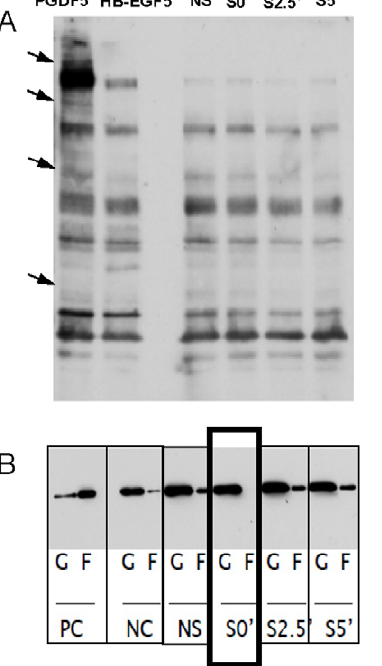
Figure 4. A major component of fluidization is F-actin disassembly: molecular blotting. (A) A transient stretch did not affect phosphotyrosine protein phosphorylation profiles. Positive control: PDGF and HB-EGF treatment for 5 minutes. (B) In contrast, a transient stretch acutely ablated F-actin levels at short times (S’0 – immediately after stretch). These levels recovered to baseline at longer times (S’2.5–2.5 minutes after stretch; S’5–5 minutes after stretch). Positive control (PC - 1 m M phalliodin), negative control (NC - 10 m M cytochalasin).